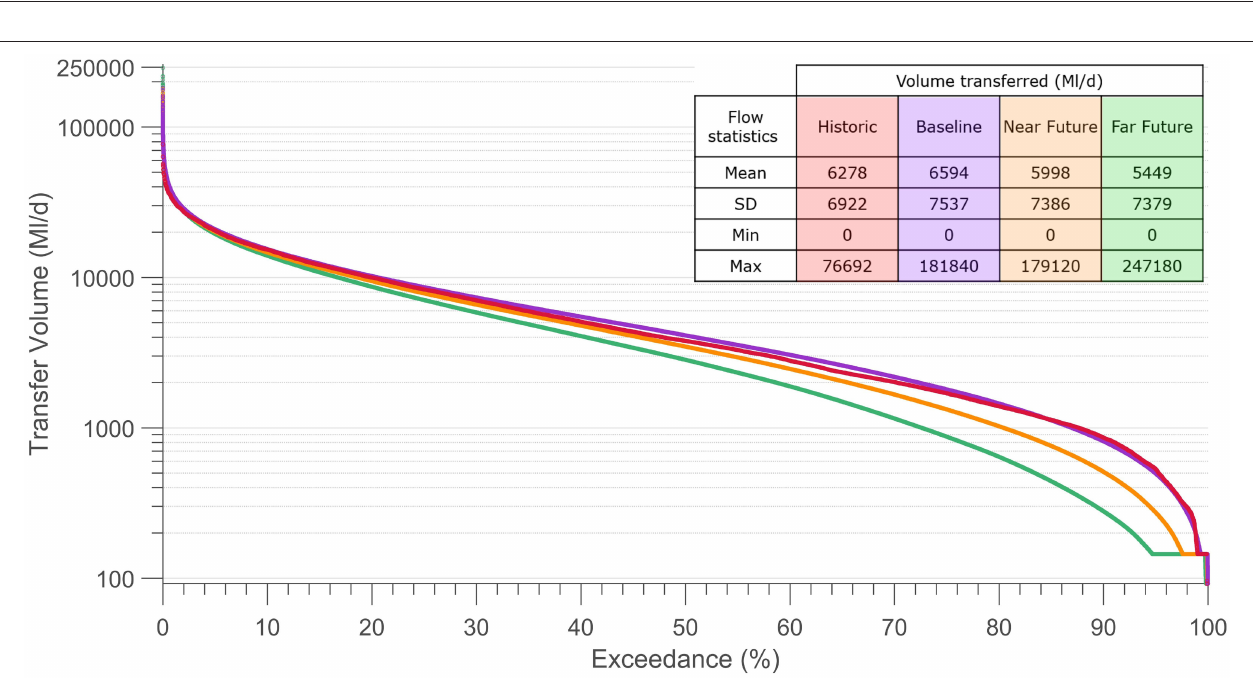
FIGURE 6 | Probability of Thames and Severn water resource regions experiencing a severe water restriction simultaneously in any given month in the Historic (circular markers, red), Baseline (diamond markers, purple), Near Future (triangular markers, orange), and Far Future (square markers, green) ensembles.